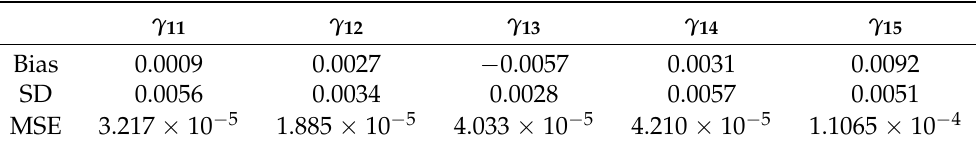
Table 4. Bias, SD and MSE evolutions with respect to the parameter γ variation for GNFPLSIM with the identity link function and n = 500.